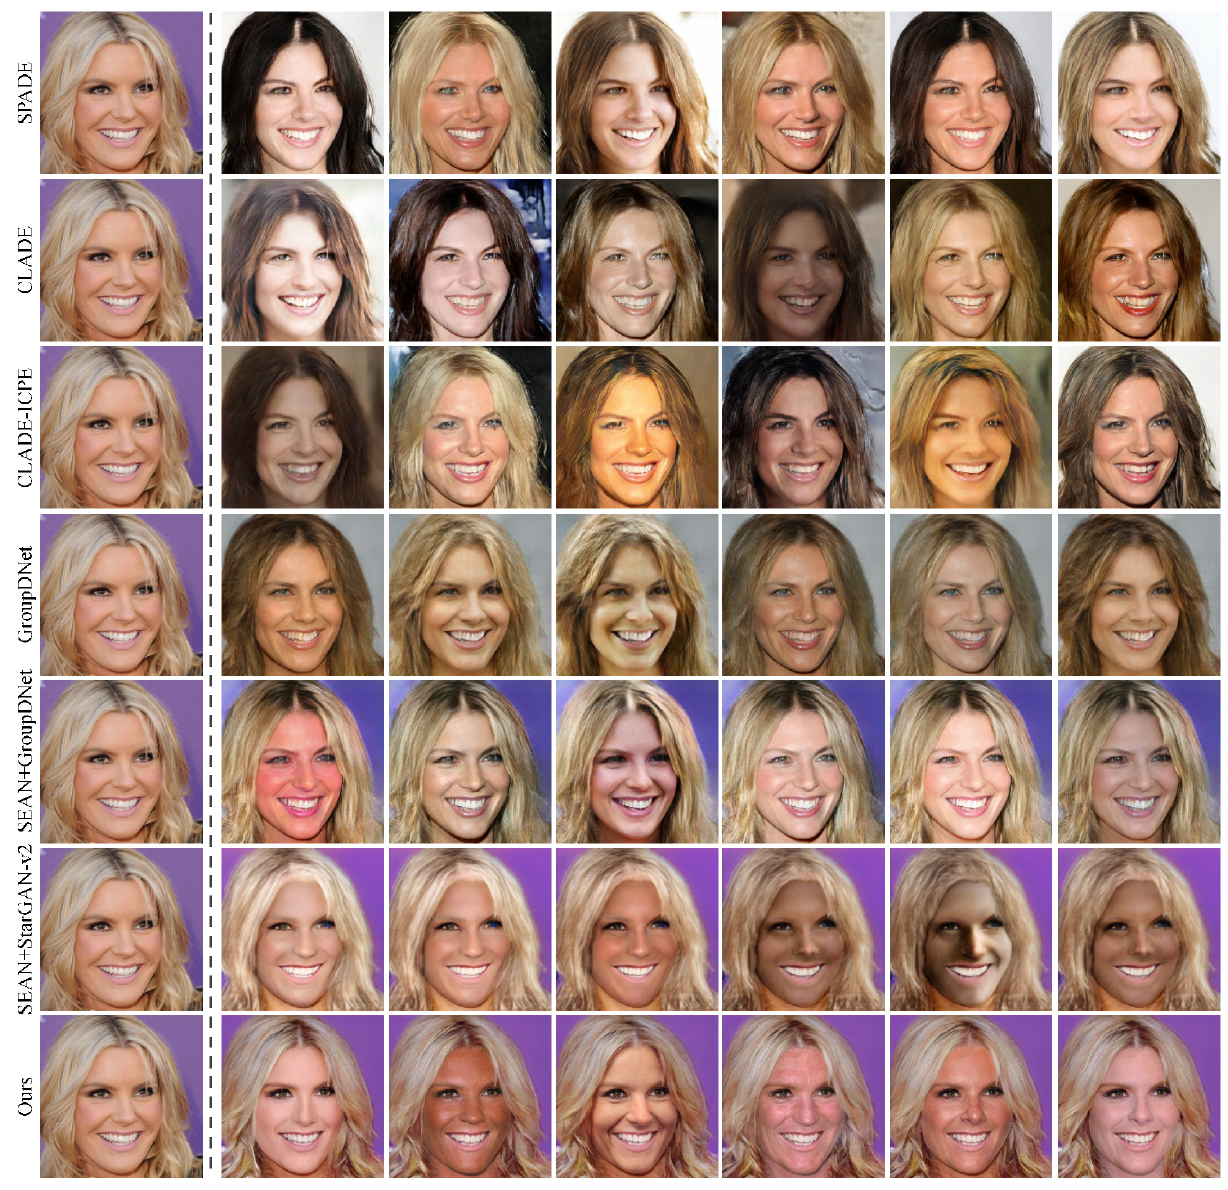
Fig. 8 Skin multi-modal